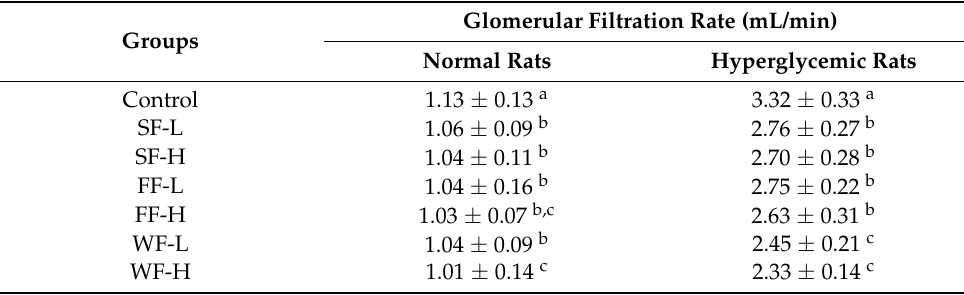
Table 7. Impact of bitter melon supplementation on glomerular filtration rate of rats.